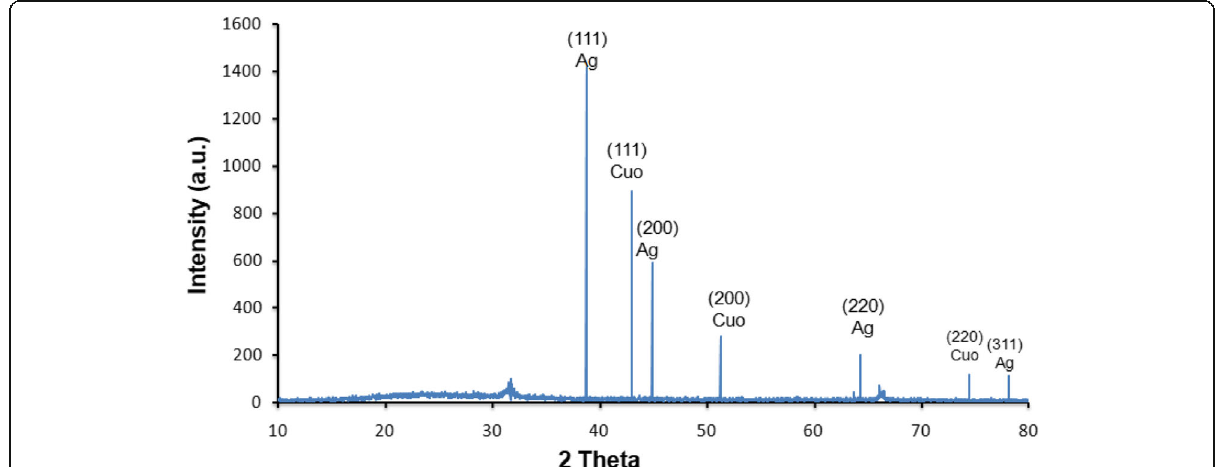
Fig. 3 XRD analysis of nano hybrid particles (Ag-CuO)